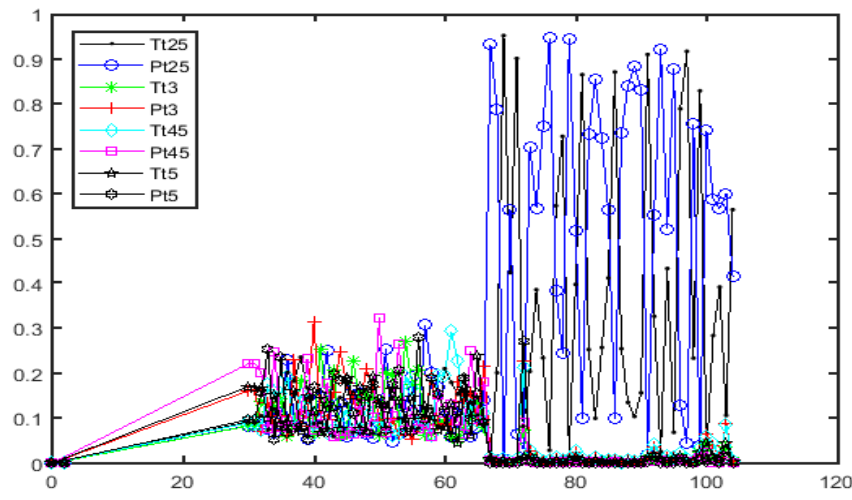
Figure 8. Sensitivity distribution spectra of the tested parameters.